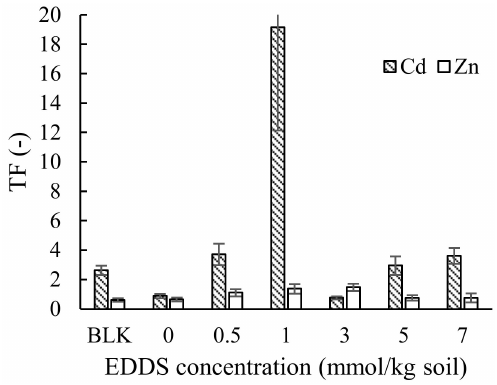
Figure 3. Effect of the EDDS concentration on the translocation factor (TF) of Cd and Zn in Taraxacum officinale (70% humidity). BLK represents the pot for no addition of heavy metals (i.e., Cd and Zn) as well as no addition of EDDS (i.e., Pot No. 1 in Table